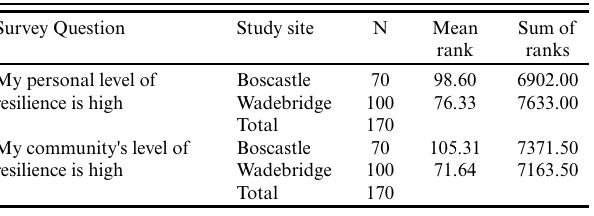
Table 5. Results from survey showing residents in Boscastle perceive having higher levels of community resilience than residents in